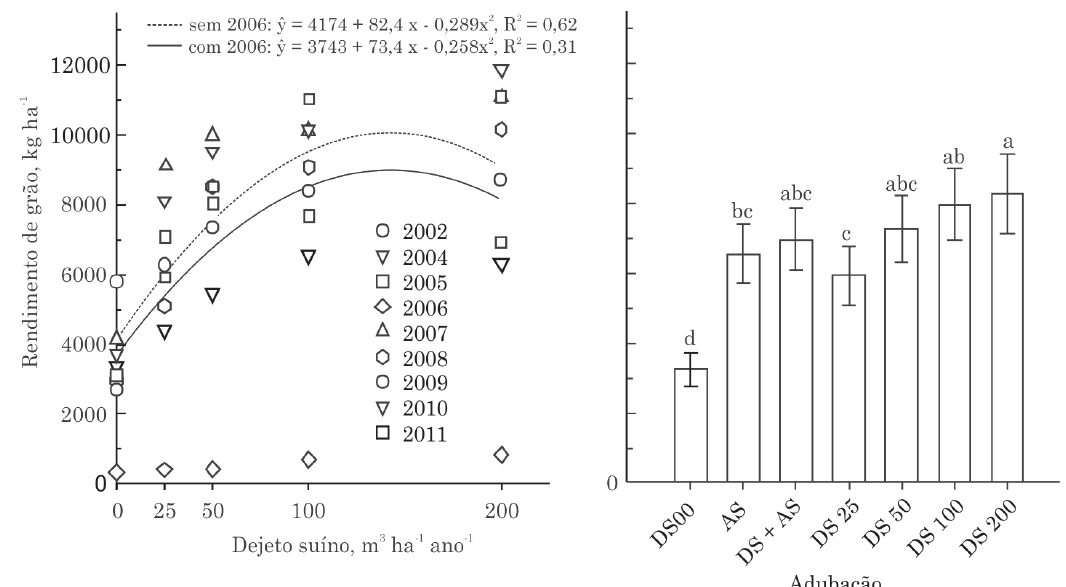
Figura 3. Rendimento anual médio de grãos de milho nas safras de 2002 e de 2004 a 2011 cultivado sob plantio direto em Latossolo Vermelho distroférrico em função de doses anuais de 0 a 200 m 3 ha -1 de dejeto suíno (a) e médias dos rendimentos obtidos em todas as safras (b) após 10 anos de adubações anuais com dejeto suíno nas doses de 0 (DS00), 25 (DS25), 50 (DS50), 100 (DS100) e 200 (DS200) m 3 ha -1 , adubo solúvel (AS) e dejeto suíno complementado com adubo solúvel (AS + DS). Colunas com letras iguais não diferem entre si pelo teste de Tukey a 5